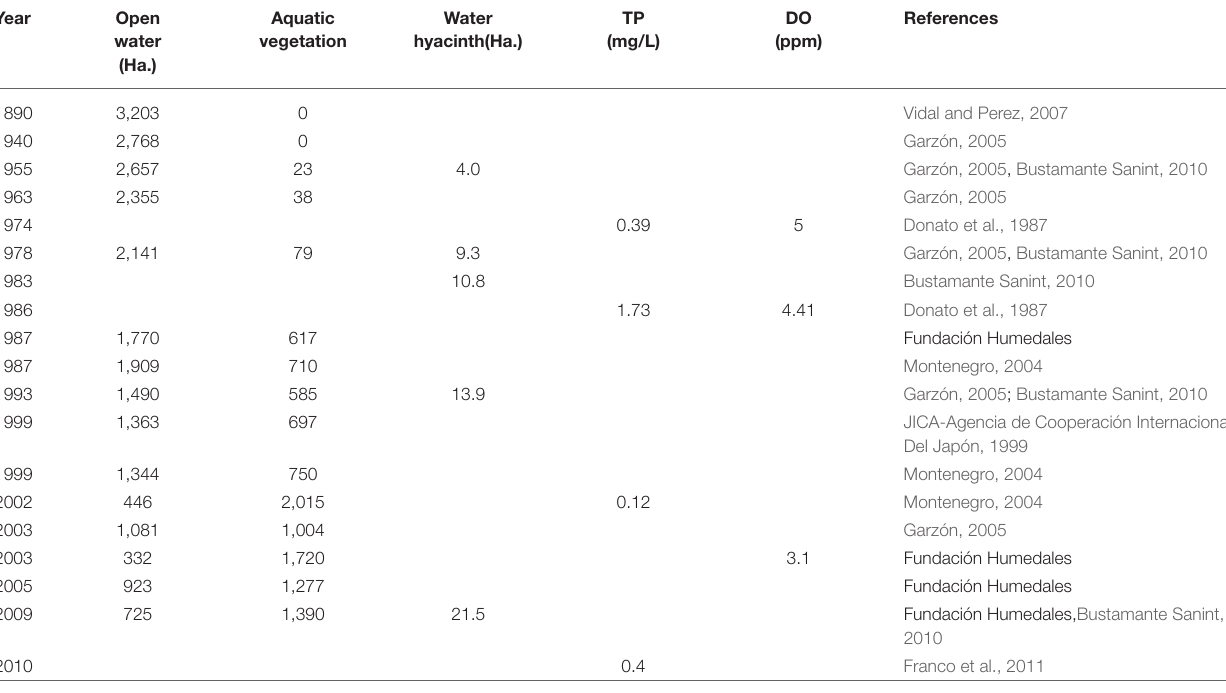
TABLE 1 | Historically records of environmental data, macrophytes and water hyacinth spread in Fúquene Lake (modified after Franco et al., 2011).